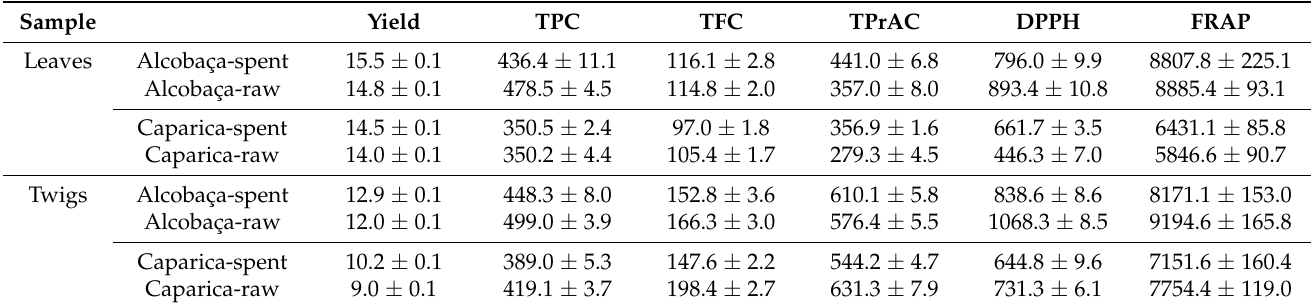
Table 4. Extract yield, composition, and antioxidant activity of extracts obtained from raw and spent leaves and twigs, using maceration at room temperature with 70% ACE as extraction